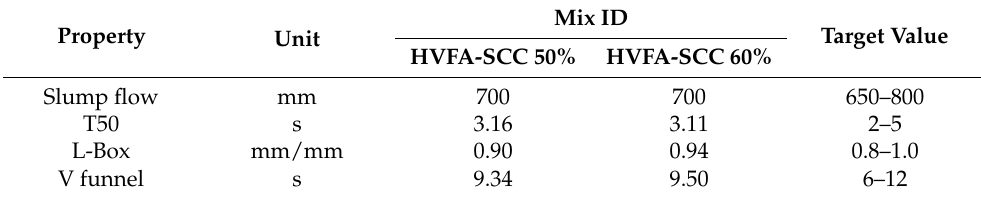
Table 3. Fresh properties of HVFA-SCC